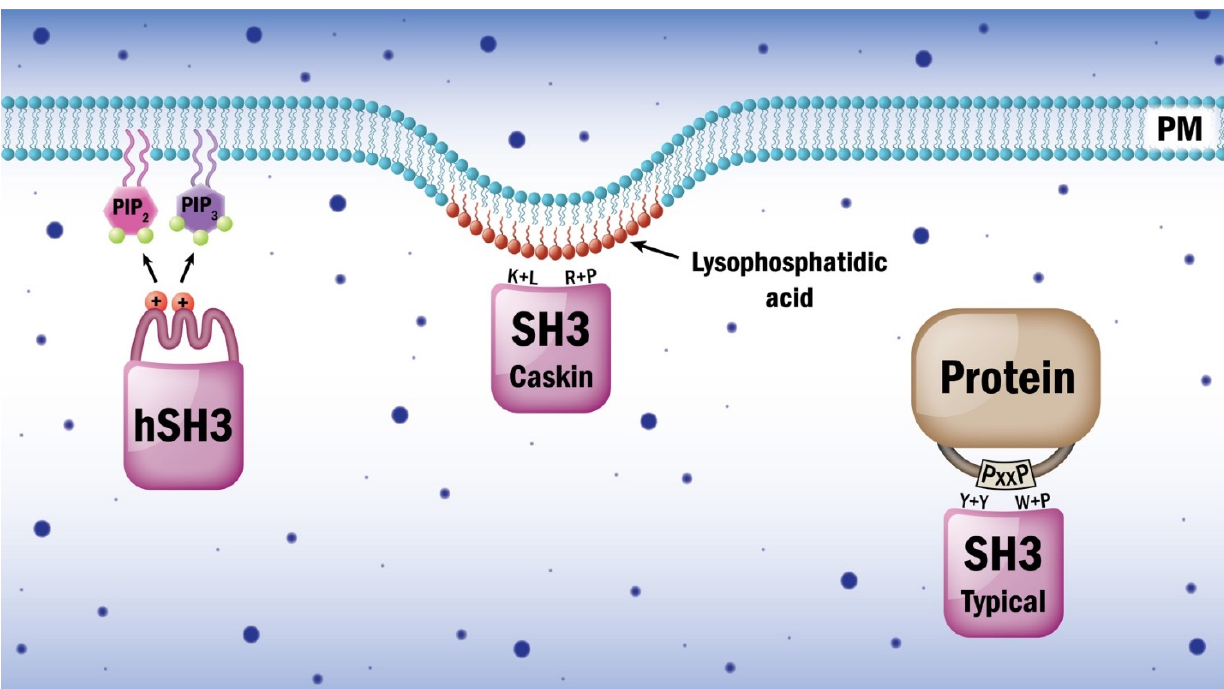
Figure 4. Some SH3 domains are involved in lipid recognition rather than protein binding. Typical SH3 domains accommodate two conserved pairs of aromatic/hydrophobic amino acids in two grooves for the attachment to two prolines in register (PXXP) on the surface of partner proteins. The helically extended SH3 (hSH3) domain identified in ADAP and PRAM-1 nests basic amino acids within an extra N-terminal helix. The composite surface created in the hSH3 domain displays cationic patches and can bind phosphatidylinositol-4,5-bisphosphate or phosphatidylinositol-3,4,5-trisphosphate but not proteins. The Caskin1 SH3 domain exchanged some proline-binding amino acids and lost the two PXXP motif-binding grooves. These changes resulted in a switch from protein to lipid binding ability. The Caskin1 SH3 domain preferentially binds to lysophosphatidic acid, a signaling-borne lipid found in positively charged membrane curvatures. Thus, hSH3 and Caskin1 SH3 domains might guide their host proteins along with their interacting partners to specific membrane sub-domains.